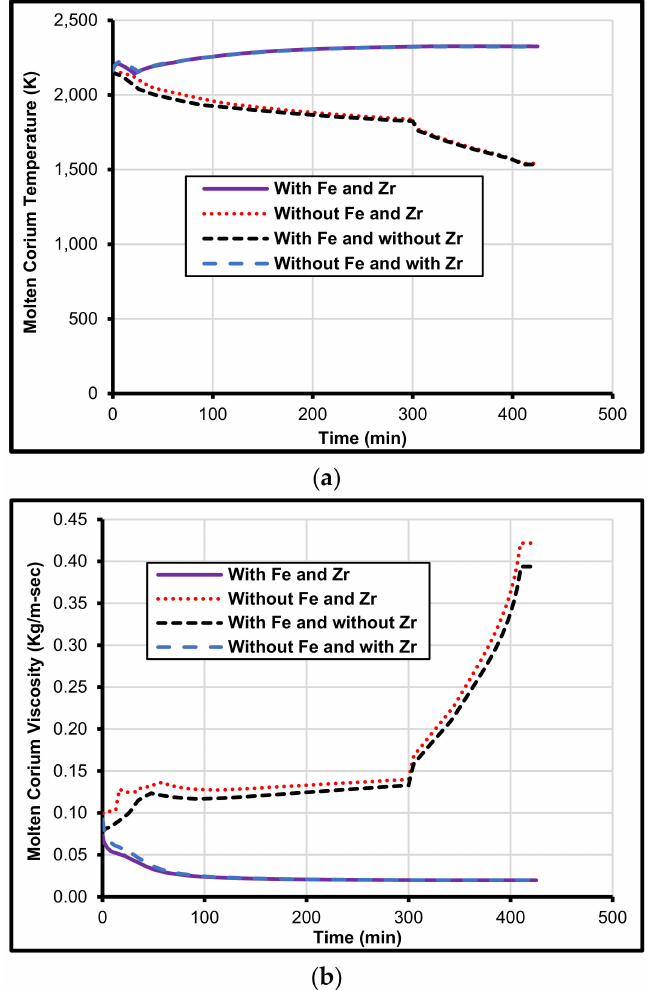
Figure 13. Effect of Fe, Zr, and their various combinations during MCCI at 425 min on ( a ) molten corium temperature and ( b ) molten corium